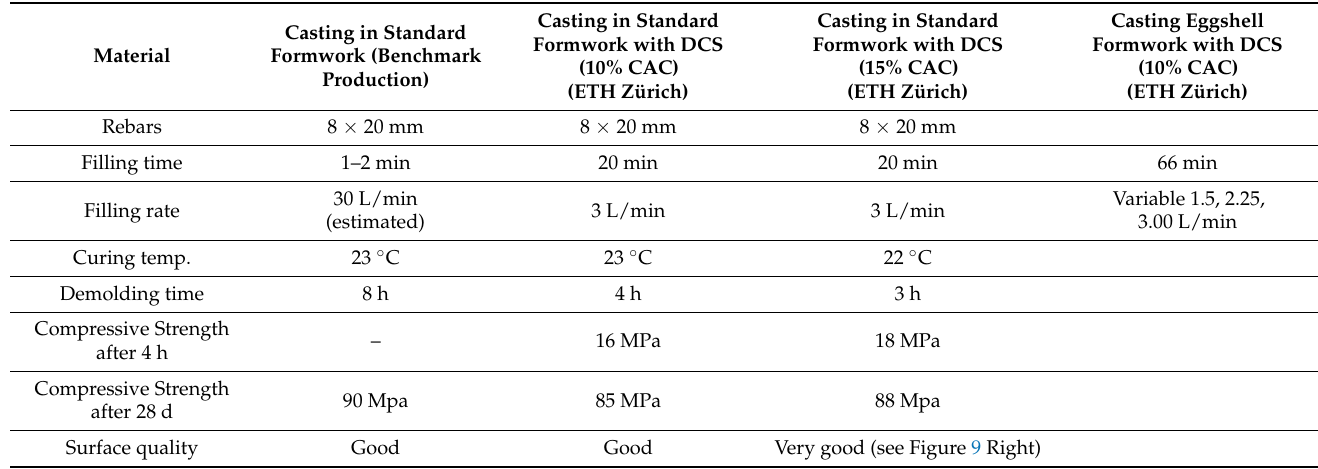
Table 4. Overview of results from experiments compared to benchmark in